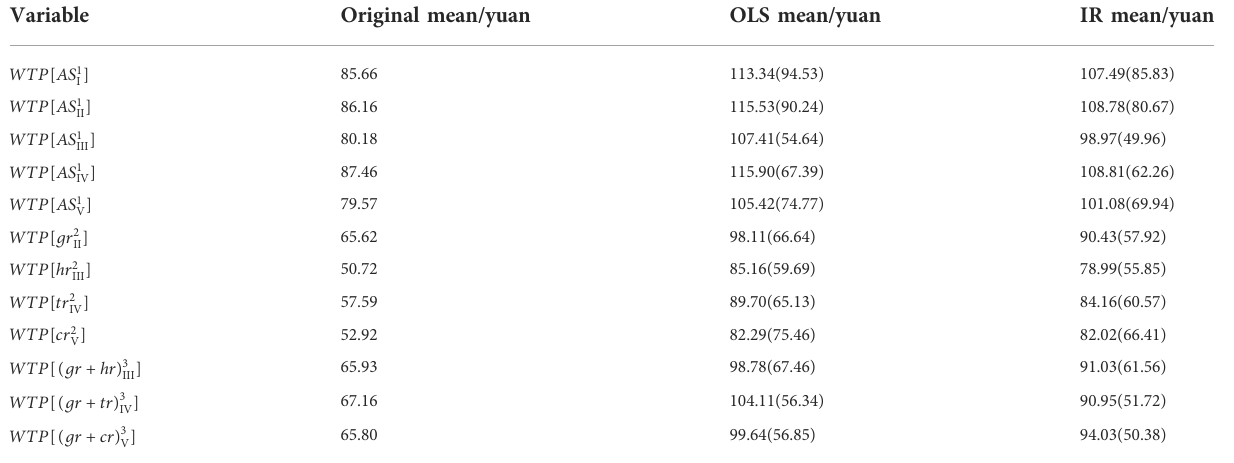
TABLE 7 Estimation results of the mean WTP. Variable Original mean/yuan OLS mean/yuan IR